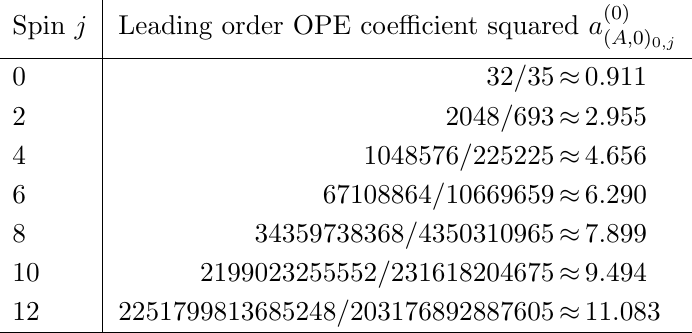
Table 3 . Values of leading order OPE coe(cid:14)cients squared a (0)